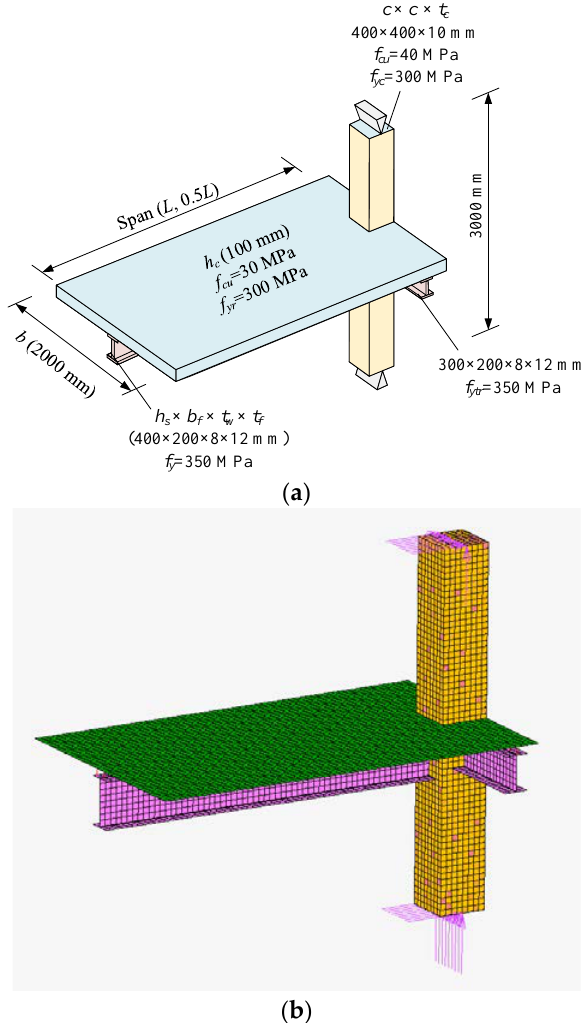
Figure 4. Finite element model. ( a ) Geometrical configuration and material properties; ( b ) finite element model established with MSC-Marc.